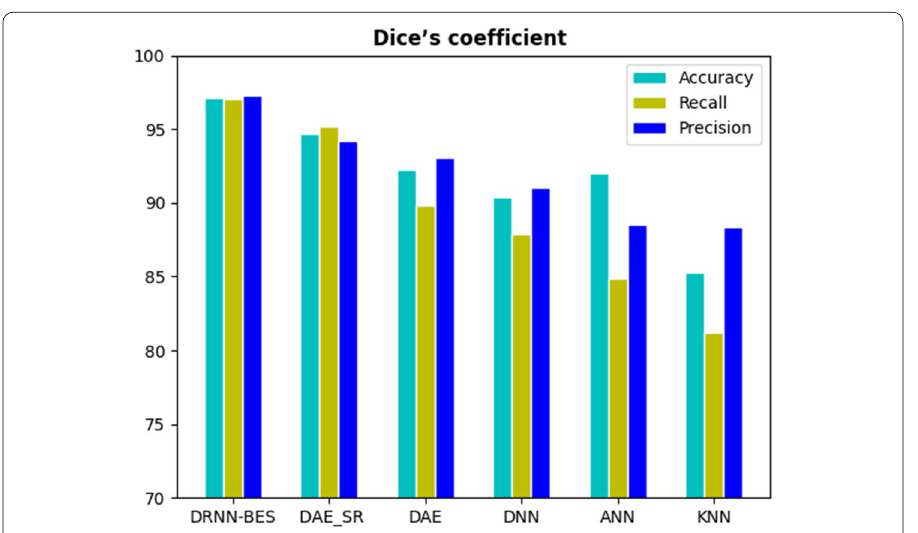
Fig. 3 Performance analysis based on Dice’s similarity